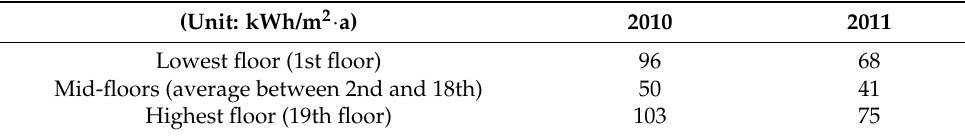
Table 3. Analysis of measured heating energy consumption by the height of